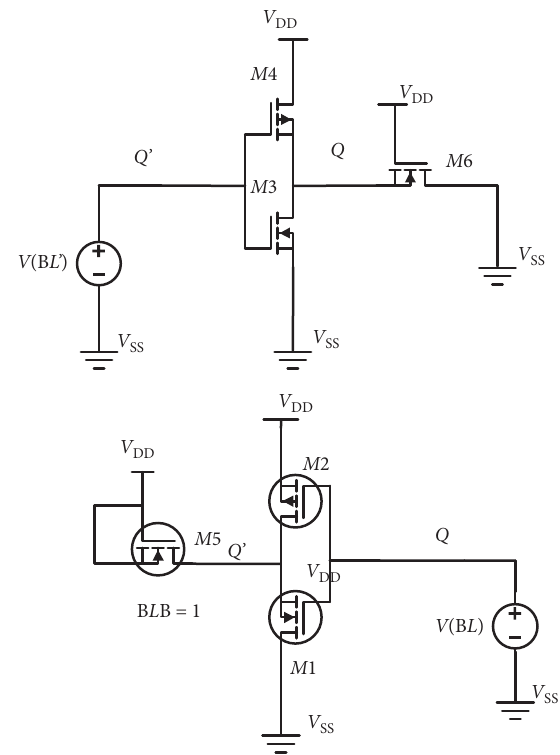
Figure 6: The schematic for butterfly curve measurement of SRAM cells in the write operation.